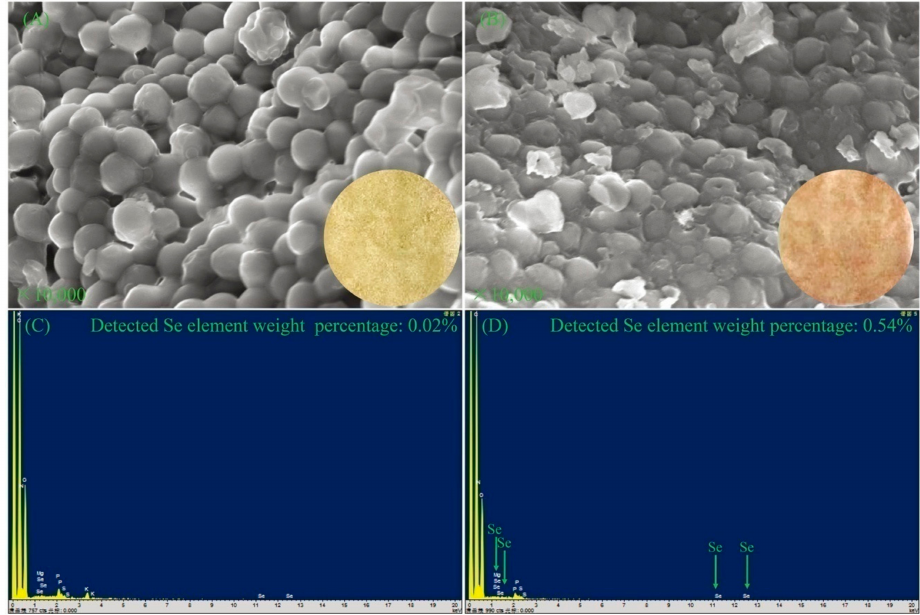
Figure 3. SEM and energy-dispersive spectrometry (EDS) for DB-yeast and Se-enriched DB-yeast. ( A ) SEM of DB-yeast. The inset image is powdery DB-yeast (yellow). ( B ) SEM of Se-enriched DB-yeast. The inset image is powdery Se-enriched DB-yeast (sandy beige). ( C ) EDS of DB-yeast. ( D ) EDS of Se-enriched DB-yeast.